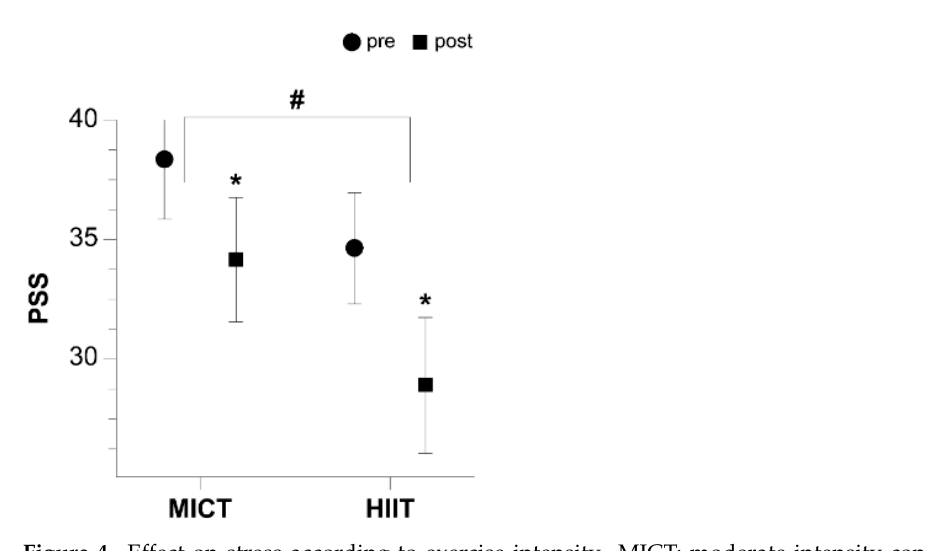
Figure 4. Effect on stress according to exercise intensity . MICT: moderate-intensity continuous training, HIIT: high-intensity interval training, PSS: Perceived Stress Scale. Bars represent mean ± SD (MICT: n = 8, HIIT: n = 8). * p < 0.05 from Pre to Post. # p < 0.05 change (post-pre) between groups. ## p < 0.01 change (post-pre) between groups